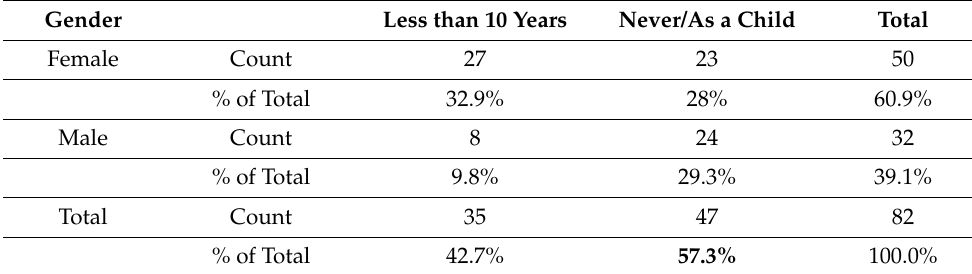
Table 1. Question 12: “When was the last time you were